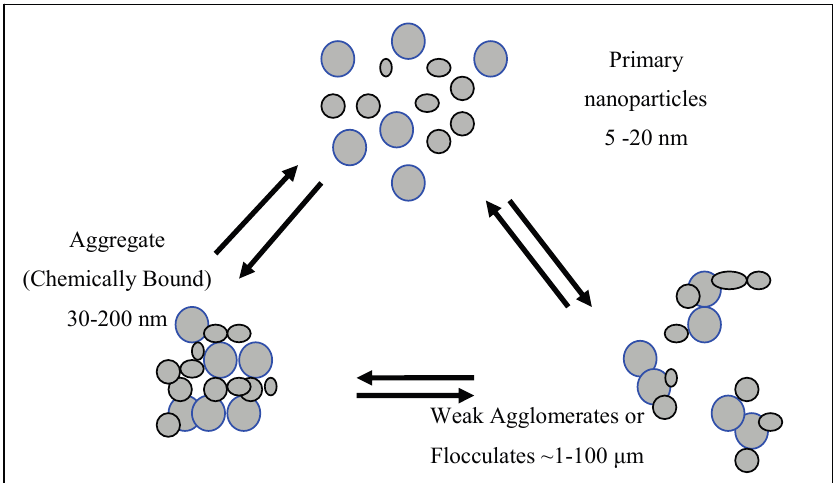
Figure 7. Schematic representation of the aggregation and agglomeration of titanium dioxide nanoparticles. Primary particles may flocculate to form weakly bound agglomerates or sinter to form much stronger aggregates. Agglomerates may sinter to form more strongly bound aggregates. Agglomerates break down more easily than